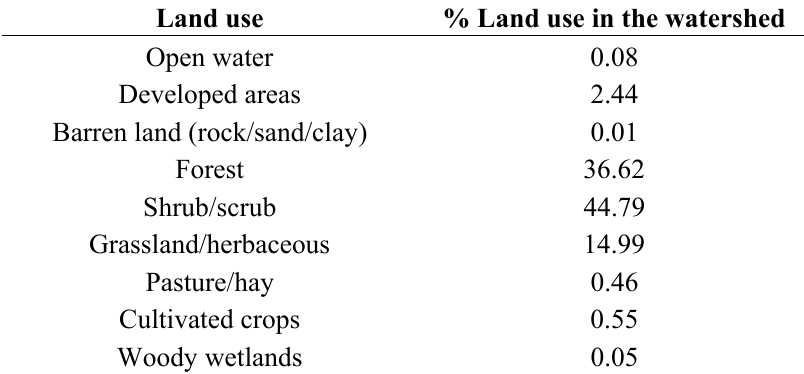
Table 1. Different land cover types and their percentages in the watershed.